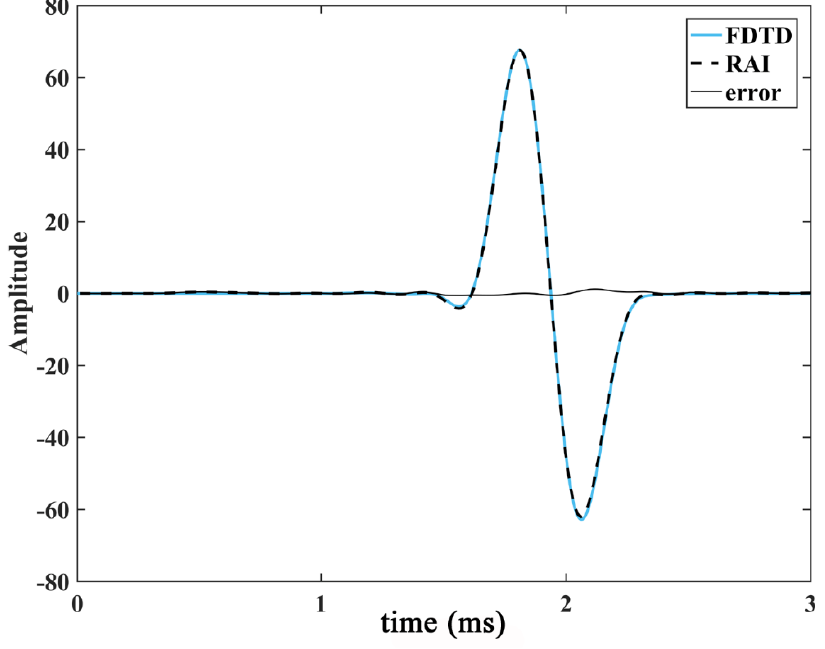
Figure 3. Stoneley (ST) waveforms propagating in a borehole surrounded by a homogeneous formation. The solid blue curve is a waveform obtained by the FD method; the dashed black curve is a waveform obtained by real-axis integration (RAI) method. The solid black curve indicates error.